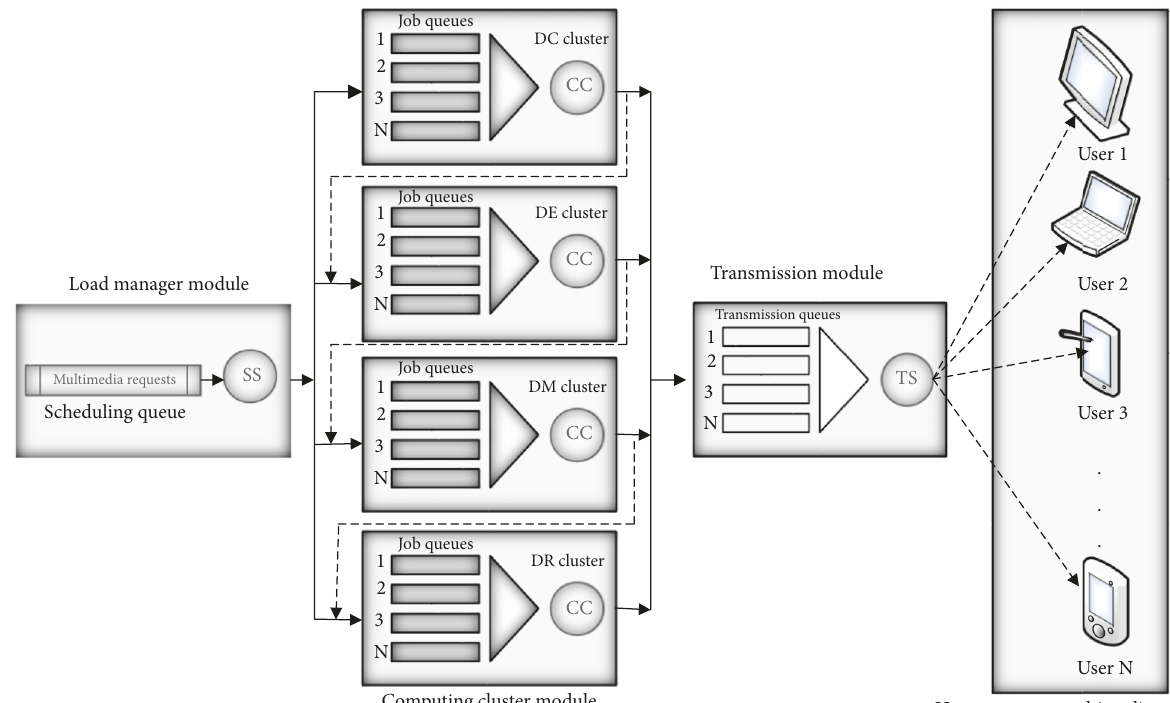
Figure 2: Multimedia cloud computing architecture.